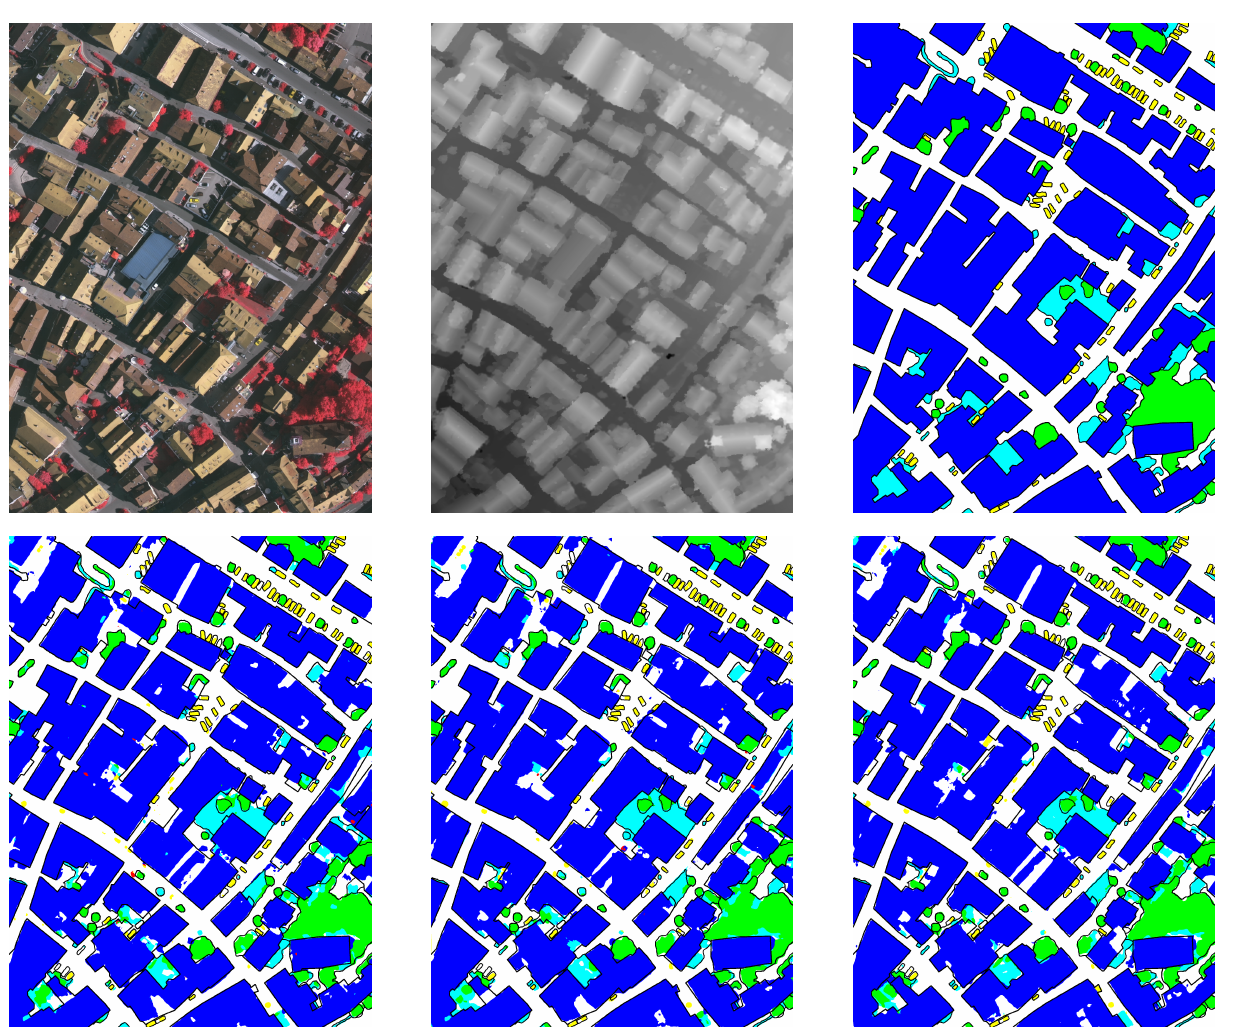
Figure 2. Top: image, DSM and ground-truth annotation. Bottom: results from single-task with image data, single-task with image and height data and from multi-task